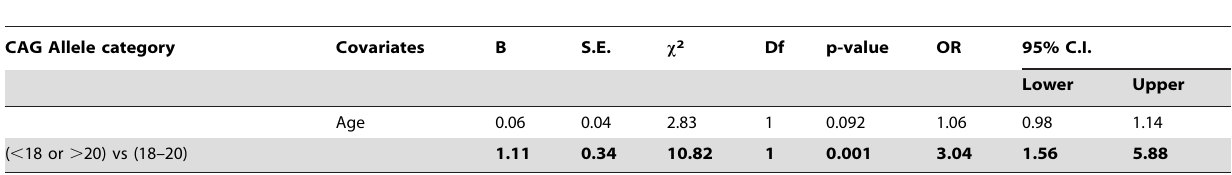
Table 5. Odds ratio for the CAG allele categories ( , 18 or . 20) VS (18–20) in the case cohort (for lean versus obese PCOS cases) taking age as